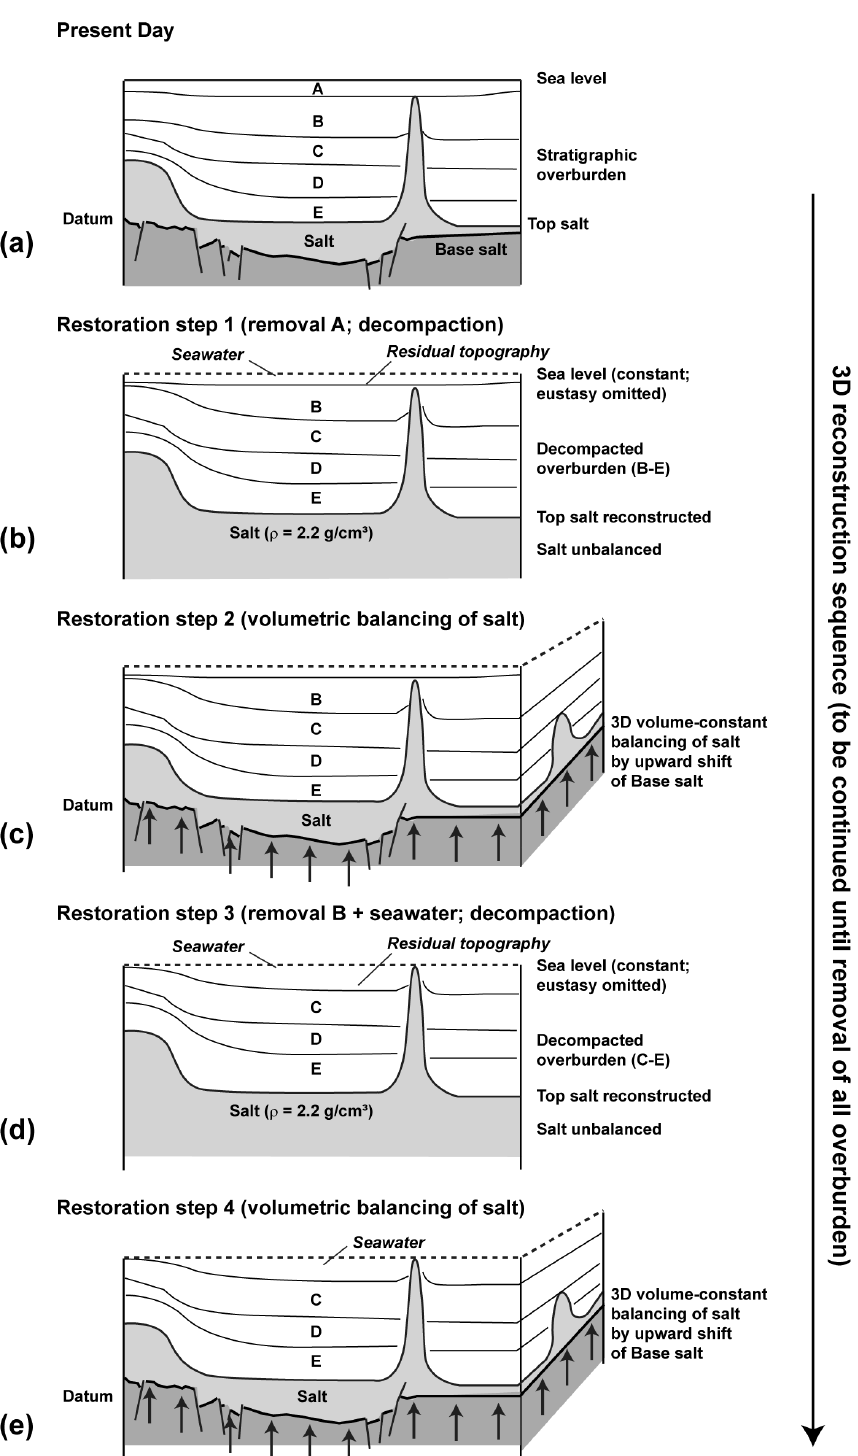
Figure 4. Restoration methodology. (a) Present-day situation. (b) Restoration step 1: removal of top layer A. Airy-type vertical unloading of sedimentary column down to top salt. Decompaction of sedimentary column down to top salt (only restoration scenarios 2 and 3). Salt unit remains unbalanced. Residual topography flooded with seawater. (c) Restoration step 2: upward vertical shift of unbalanced base salt into new position constrained by keeping salt volume constant. (d) Same as restoration step 1 but removal of new top layer B. (e) Same as restoration step 2 with remaining stratigraphy. Entire 3D unloading procedure to be continued until removal of all salt overburden (Fig. 5).